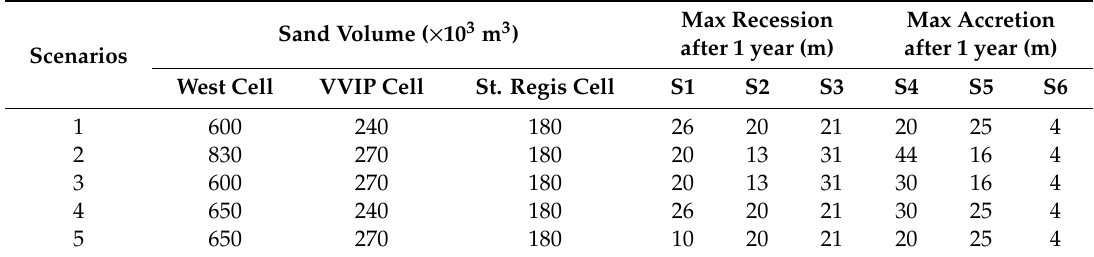
Table 4. Maximum accretion / erosion occurred after 1 year, for the proposed scenarios.